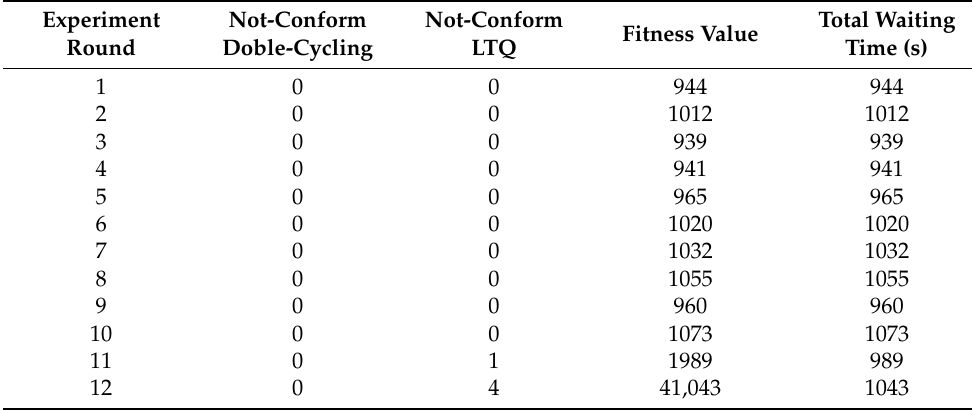
Table 6. Results of multiple experiments in our double-cycle